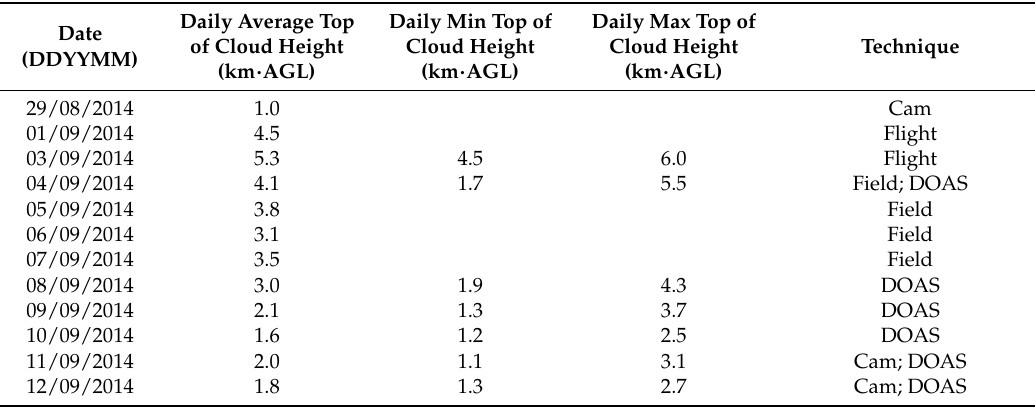
Table 3. Observations of height of eruption cloud made by ground- and aircraft-based observations, web camera, ScanDOAS, MobileDOAS, and NICAIR II IR